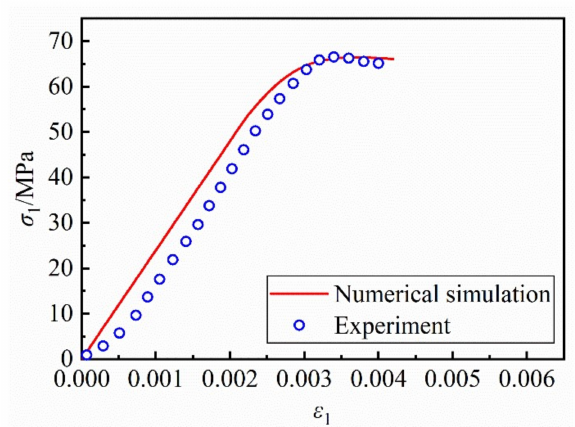
Figure 11. Uniaxial compression stress-strain curve of Indian limestone.